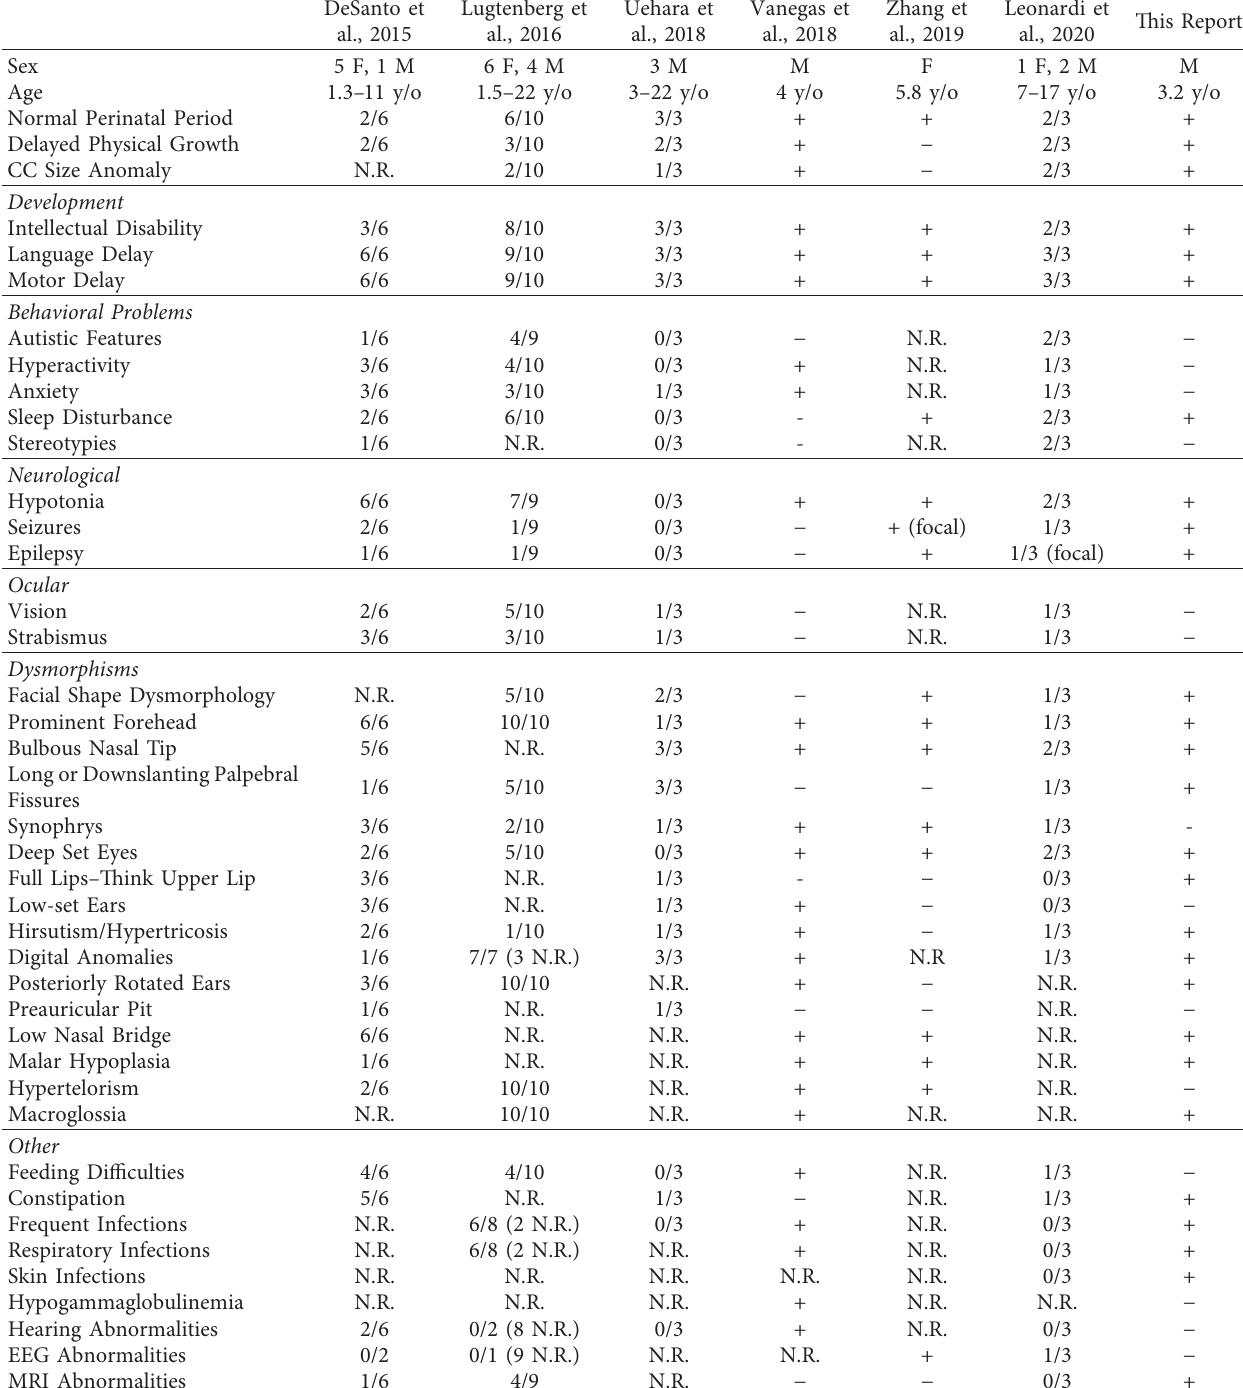
Table 1: Findings in comparison with previously reported WAC cases in the literature. The dysmorphic features reported in Zhang et al., 2019 [8] is presented in this table according to the clinical illustration found in https://www.sohu.com/a/354042751_387855. CC, cranial circumference; N.R., not reported; +, present; − ,